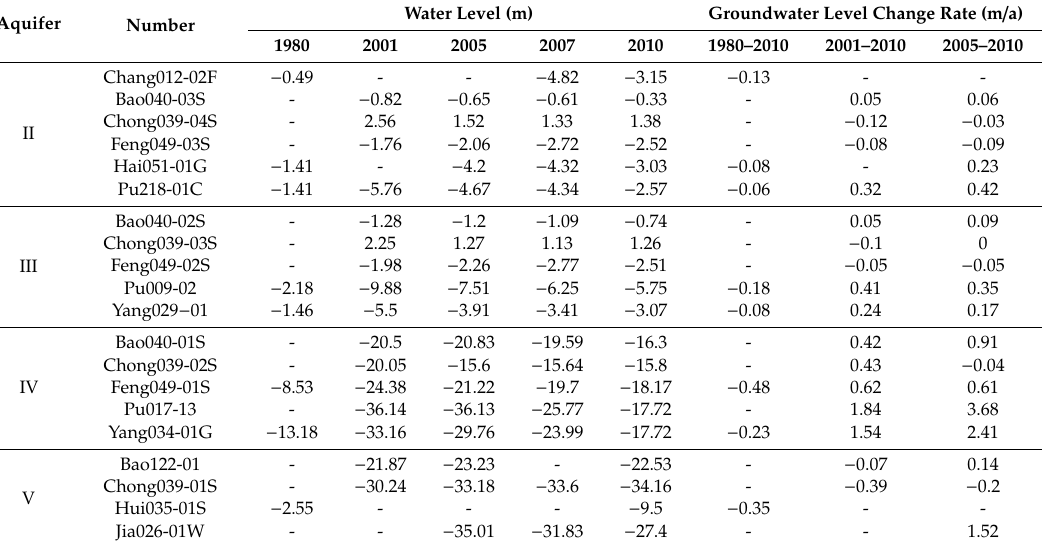
Table 5. Changes in groundwater level from typical observation wells in di ff erent Shanghai aquifers.